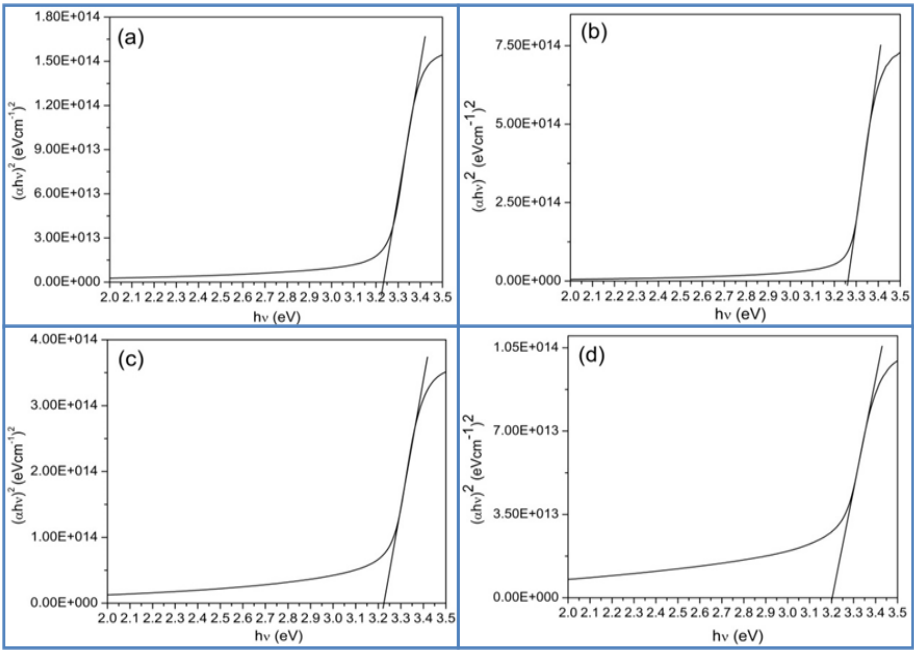
Figure 14. Variation of ( α h ν ) 2 versus applied energy (h ν ) of the synthesized ZnO nanorods using conventional CBD method at several precursor concentration, ( a ) 0.01 M, ( b ) 0.025 M, ( c ) 0.05 M and ( d ) 0.075 M. Crystals 2019 , 9 , x FOR PEER REVIEW